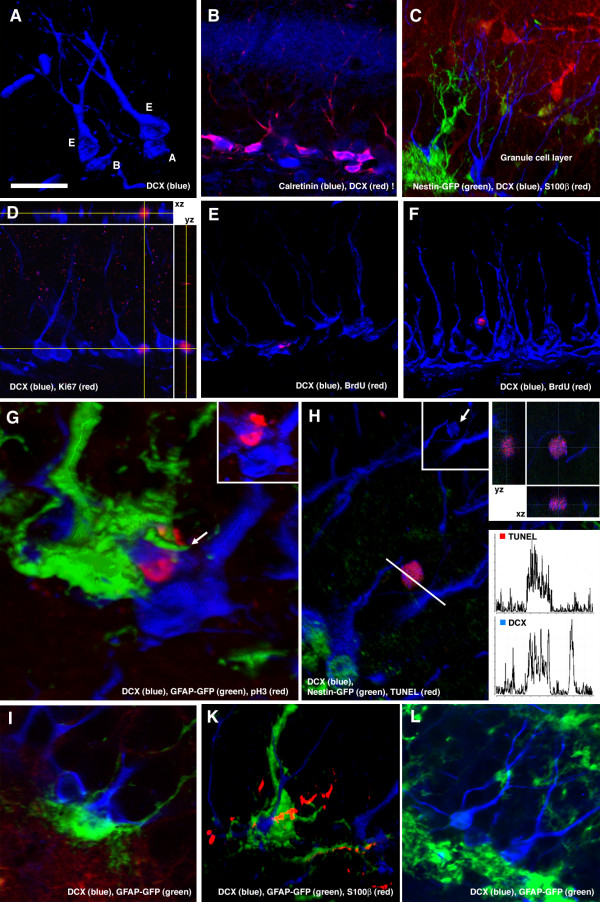
Confocal microscopy of DCX-positive cells. A, three-dimensional reconstruction of confocal microscopic z-series through sections stained for DCX expression. Two cells with no or short processes (A and B) are shown and two examples of cells in category E. Among all DCX-positive cells, category E is most abundant, accounting for more than 50% (see Fig. 4B) of the cells. Scale bar (in A for all panels), 30 μm. B, Co-localization of DCX and calretinin (CR) expression. CR expression identifies a postmitotic phase of granule cell development [8]. About 70% of all CR-positive cells are DCX-positive. The remaining DCX-positive CR-negative cells can be found in all categories except F (cf. Fig. 6B). Conversely, as depicted here, CR-positive cells can be found in all six categories. This also implies that (as suggested by the morphology) cells in categories A and B become postmitotic. The time span between exit from the cell cycle and the onset of CR expression varies. Single optical plane. Scale bar, 70 μm. C, many DCX-positive cells are in close contact to nestin-positive radial cells, here visualized in a nestin-GFP reporter gene mouse [19, 69]. These "vertical astrocytes" are considered the stem cells of the neurogenic region of the SGZ [1]. They are consistently S100β-negative [5]. 3-D reconstruction. Scale bar, 100 μm. D, Ki67 identifies a DCX-expressing cell with category A morphology as dividing. The panels to the right and on the top depict reconstructions from a confocal z-stack in xz and yz direction to confirm that the Ki67-positive nucleus belongs in fact to the DCX-positive cell. Scale bar, 70 μm. E, three-dimensional reconstruction of a BrdU-labeled cell with B morphology, 4 h after BrdU-injection. Scale bar, 70 μm. F, three-dimensional reconstruction of a BrdU-labeled cell with D morphology, 3 days after BrdU-injection. Scale bar, 70 μm.G, DCX-positive cells of all six morphological categories can be found in contact with astrocytes. In this example, during mitosis a GFAP-GFP-positive process surrounds the dividing DCX-expressing cell in the division plane. The separated sets of chromosomes were visualized with immunohistochemistry against phosphorylated histone H3 (red). Scale bar, 15 μm. H, apoptotic cells in the SGZ and granule cell layer were visualized with the TUNEL method (red). In the adult SGZ, TUNEL-positive cells are rare. Only 32 cells were found in 37 animals. Of these, a substantial number were DCX-positive (arrow in inset; DCX, blue), implying that cell death occurs indeed on the level of DCX expression. Co-localization was further demonstrated by placing virtual slices in yz and xz direction through the cell in question (top right) and by measuring the intensity of the fluorescent signals along a line placed across the cell (bottom right). The curves for the TUNEL signal (top, red) and DCX (bottom, blue) are at the same position. Single optical plane. Scale bar, 50 μm. I, the processes of GFAP-positive cells that engulf DCX-positive cells sometimes form a basket "cradling" the DCX-expressing cell. 3-D reconstruction. Scale bar, 15 μm. K, the vertical astrocytes with their close spatial relationship to DCX-positive cells are negative for S100β (red), whereas processes of horizontal astrocytes (arrow) are positive for GFAP-GFP and DCX. 3-D reconstruction. Scale bar, 50 μm. L, not all DCX-positive cells have close contact to astrocytes as visualized with the GFAP-GFP reporter gene mouse. 3-D reconstruction. Scale bar, 50 μm.